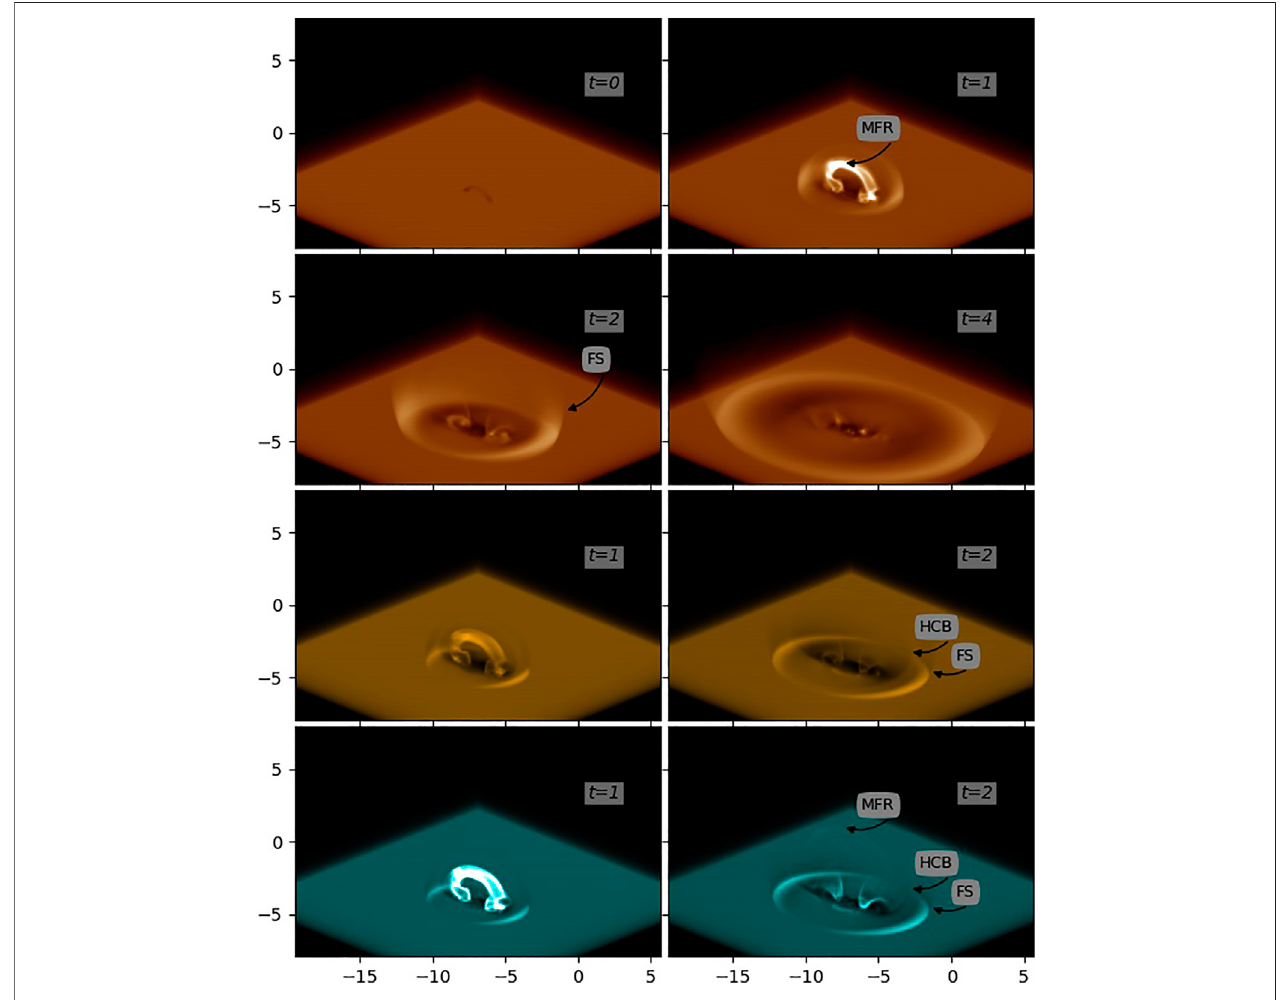
FIGURE 5 | Synthetic images of AIA 193Å (upper two lows) , 171Å (third low) and 131Å (bottom low) in the plane-of-the-sky (POS) with view angles L (cid:2) − 45 ° and B (cid:2) 60 ° at different times.